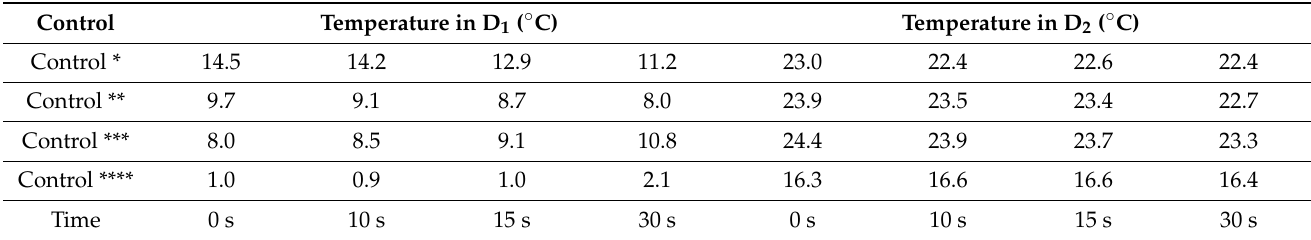
Table 2. Temperature measurement of the control during cryo-application.